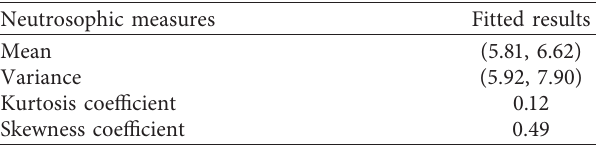
Table 4: Descriptive statistics of mean incubation period data using the proposed neutrosophic